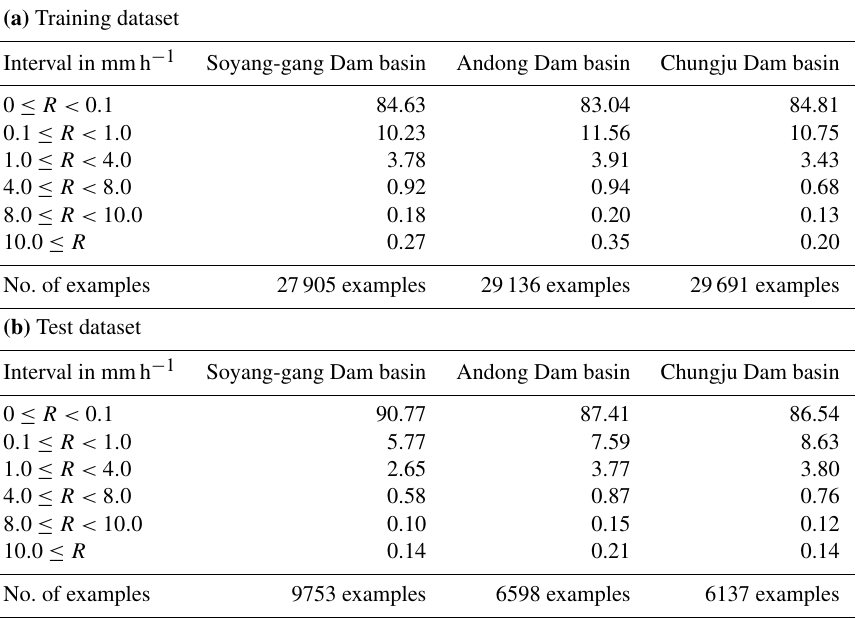
Table 1. Distribution of precipitation amount and the number of examples of (a) the training dataset, and (b) the test dataset of each dam